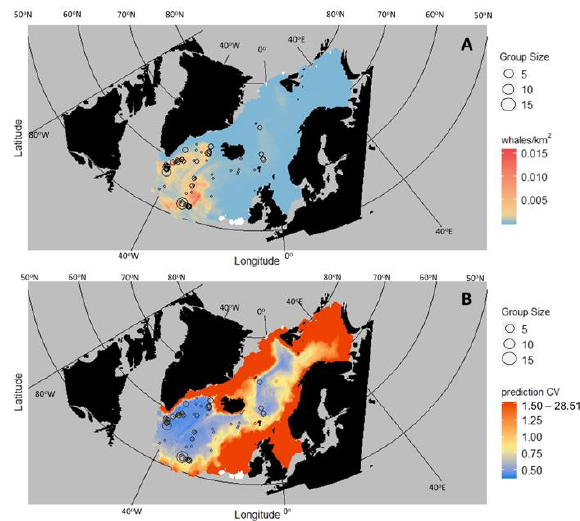
Figure 4. Panel A: Predicted sei whale distribution in the North Atlantic based on the full model and environmental covariates averaged over 1998-2015. White areas are outside predictive space. Panel B: Coefficients of variation of average predictions. Blue shows areas of highest precision. In both panels the circles show sightings of sei whale groups made on all surveys between 1998-2015, with size scaled to number of individuals in each group.